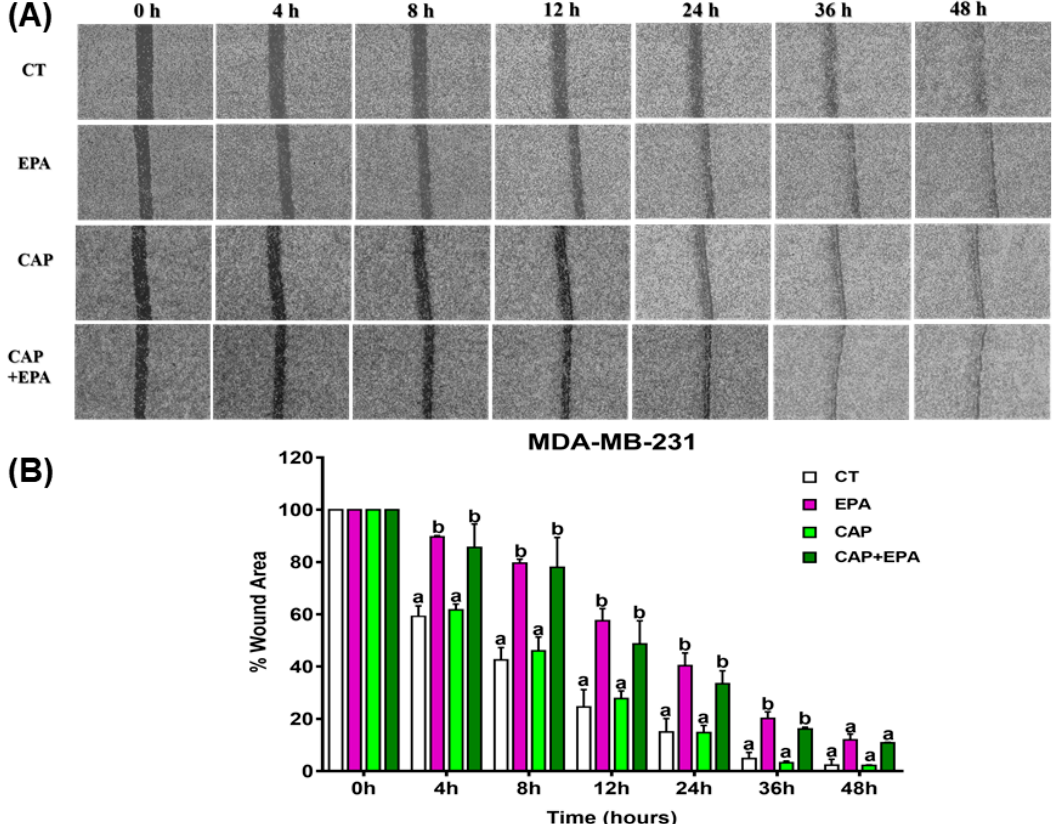
Figure 4. Direct effect of captopril and EPA on cell migration in MDA-MB-231 cells. Representative wound healing images at 0, 4, 8, 12, 24, 36, and 48 h. Wounds were inflicted with a 200 uL pipette tip on MDA-MB-231 ( A , B ) cells in confluent monolayers. Graphical representation of migrating MDA-MB-231 ( A , B ) cells in response to CAP with or without EPA treatments of BC cells. Cells treated with regular Dulbecco’s Modified Eagle’s Medium (DMEM) with 1% bovine serum albumin (BSA) conjugation were used as controls (BSA). Bars represent mean of the percent wound area in MDA-MB-231 ( A , B ) cells in the two independent experiments ± SEM. p < 0.05 (comparison between 0 and 48 h; N = 2 combined experiments, in which each had three replicates per treatment group). Different letters (a, b) indicate significance.